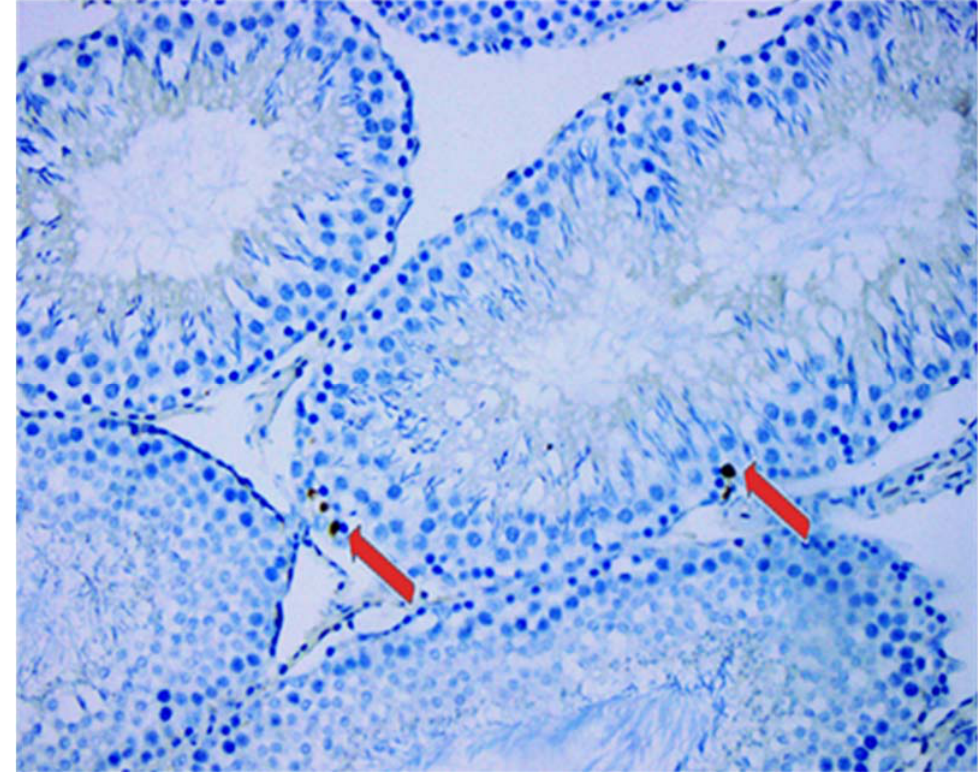
Figure 3. Immunohistochemical analysis of apoptotic activity. Positive immunostaining for cleaved caspase 3 in germ cells (red arrow), magnification ×40. caspase 3 in germ cells (red arrow), magnification ×